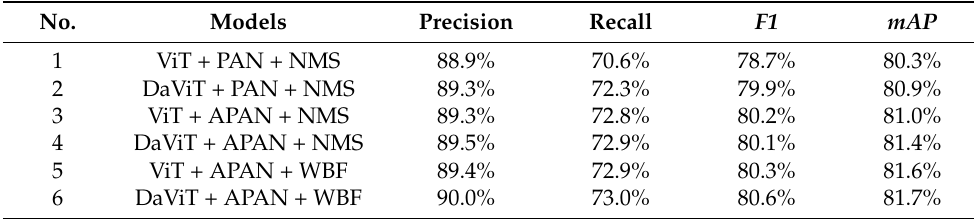
Table 7. Ablation experimental results on the DIOR